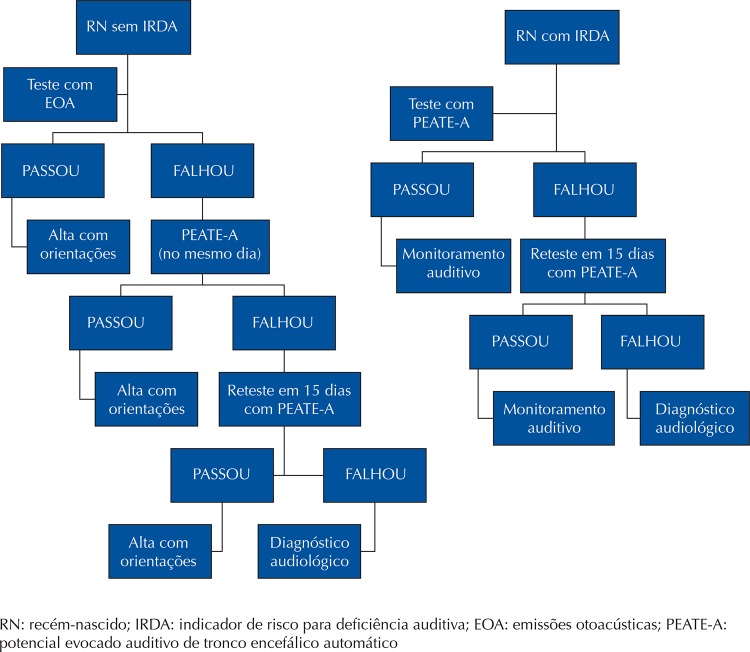
Protocolo de triagem auditiva neonatal adotado.